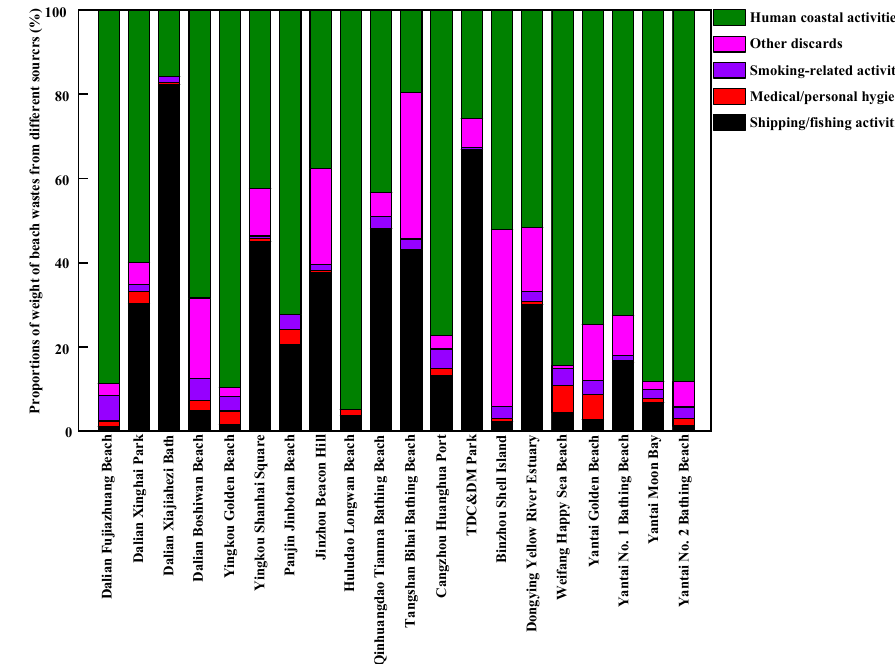
Figure 10. The proportions of beach waste from different sources in coastal cities around the Bohai Sea of China in the tourist peak season, by weight. The second greatest source of beach waste was shipping/fishing activity. This mainly included buoys, ropes and fishing nets. By quantity and weight, the average proportions